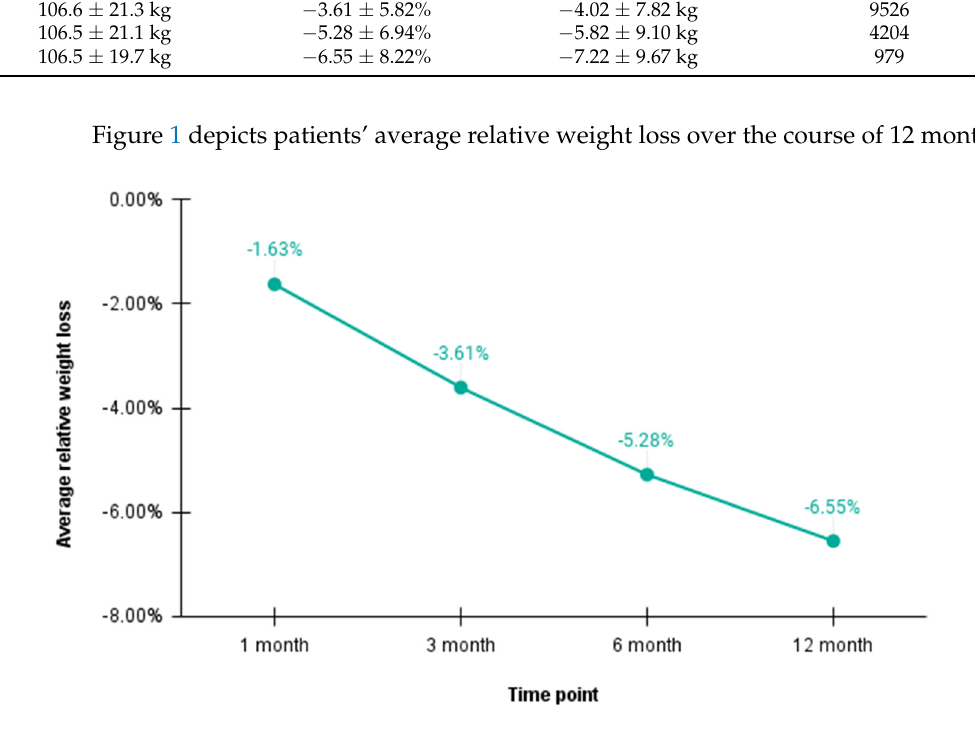
Figure 1. Average relative weight losses (in percent. compared to average baseline weight) at 1, 3, 6, and 12 months.